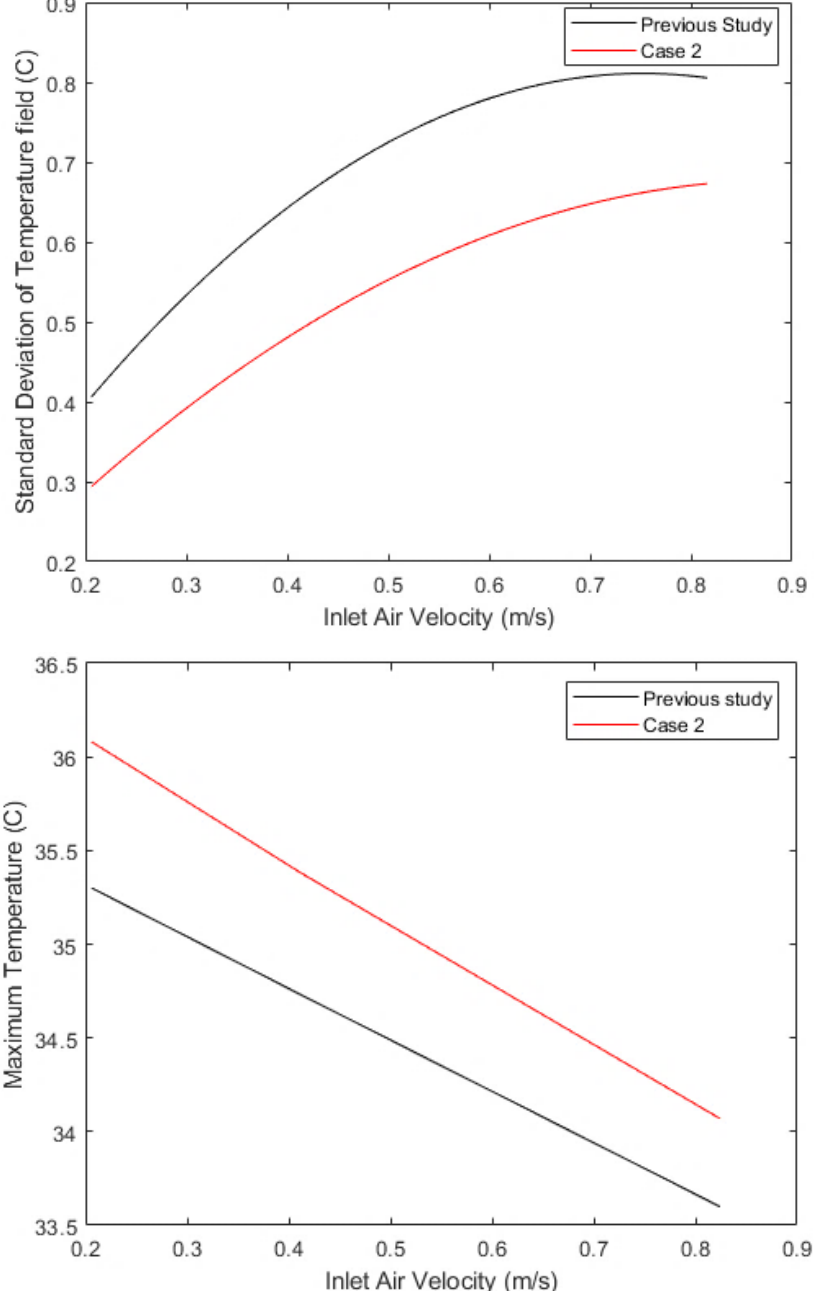
Figure 10. Comparison of Case 2 with a previous study under different inlet air velocities at 27ºC, 2C discharge rate and t =